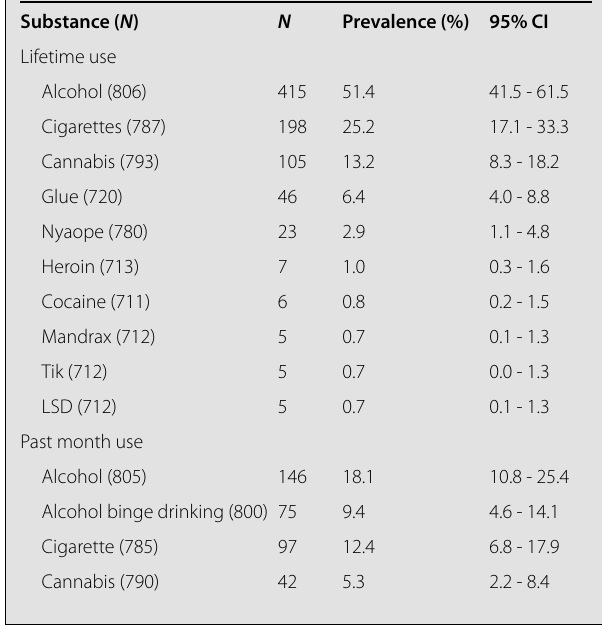
Table 1. Prevalence rates of substance use